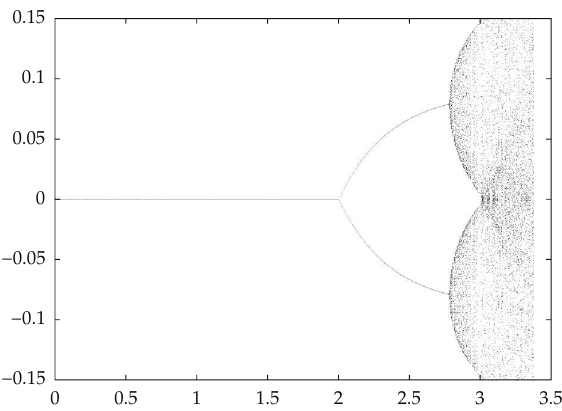
Figure 1: Orbit diagram: Log of asset price P for varying trading aggressiveness N .